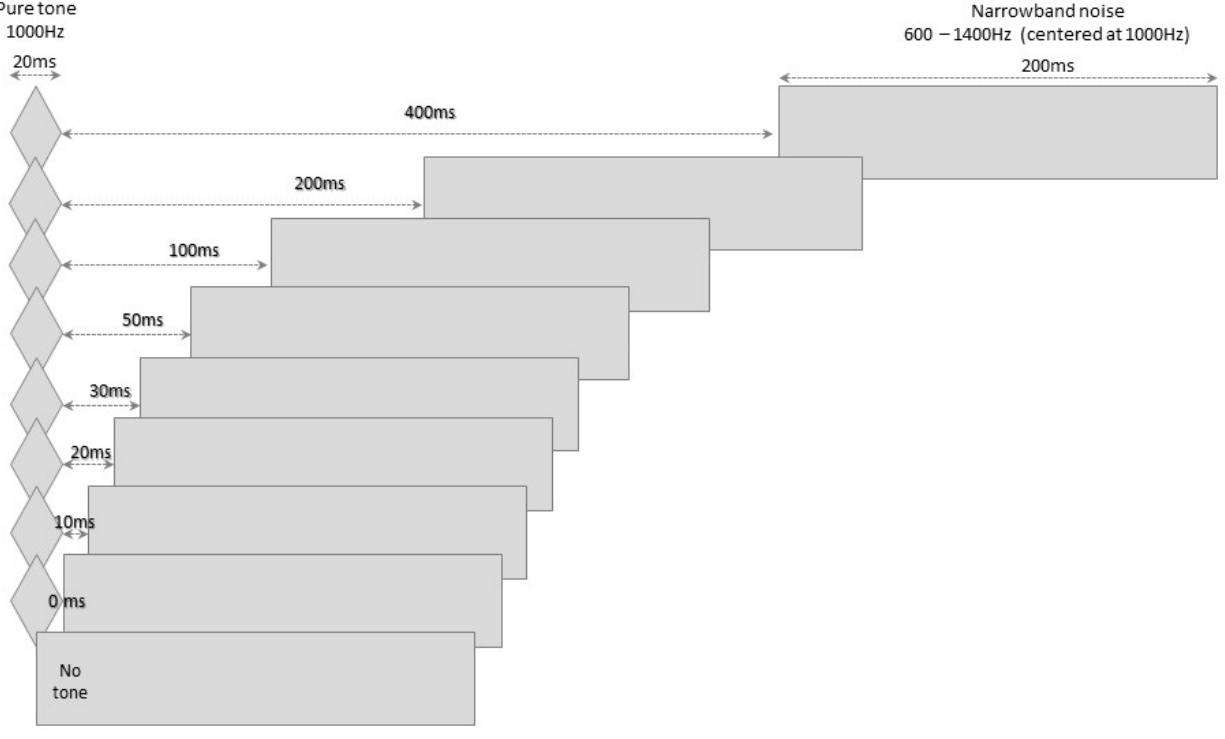
Figure 1. Representation of the stimuli and intervals of the backward masking test.